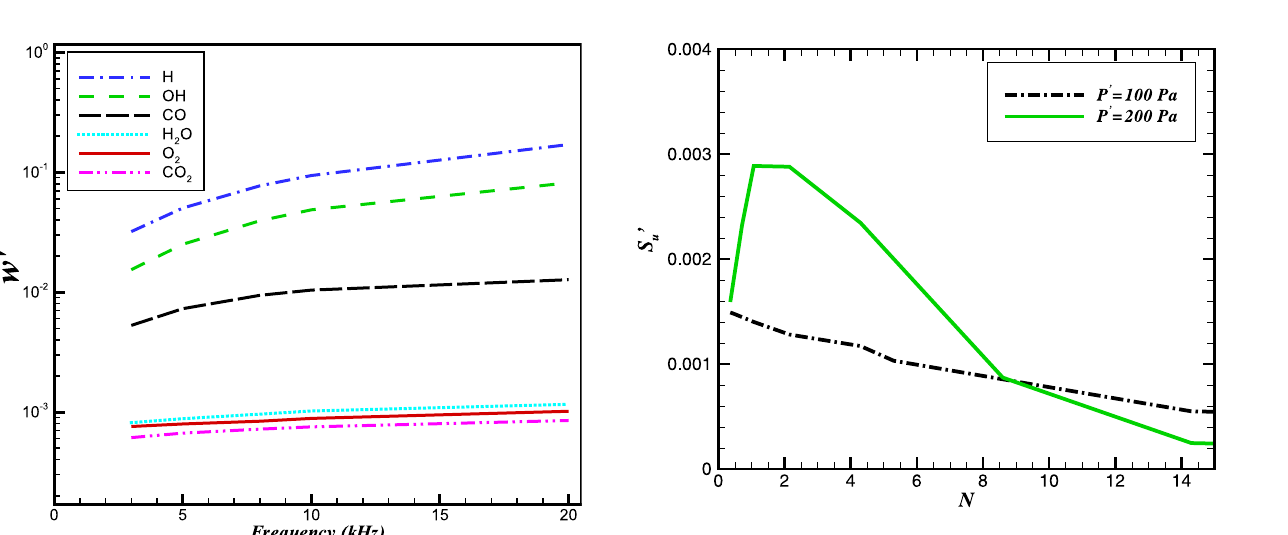
Figure 20. Relative change in the burning velocity vs length scale ratio N